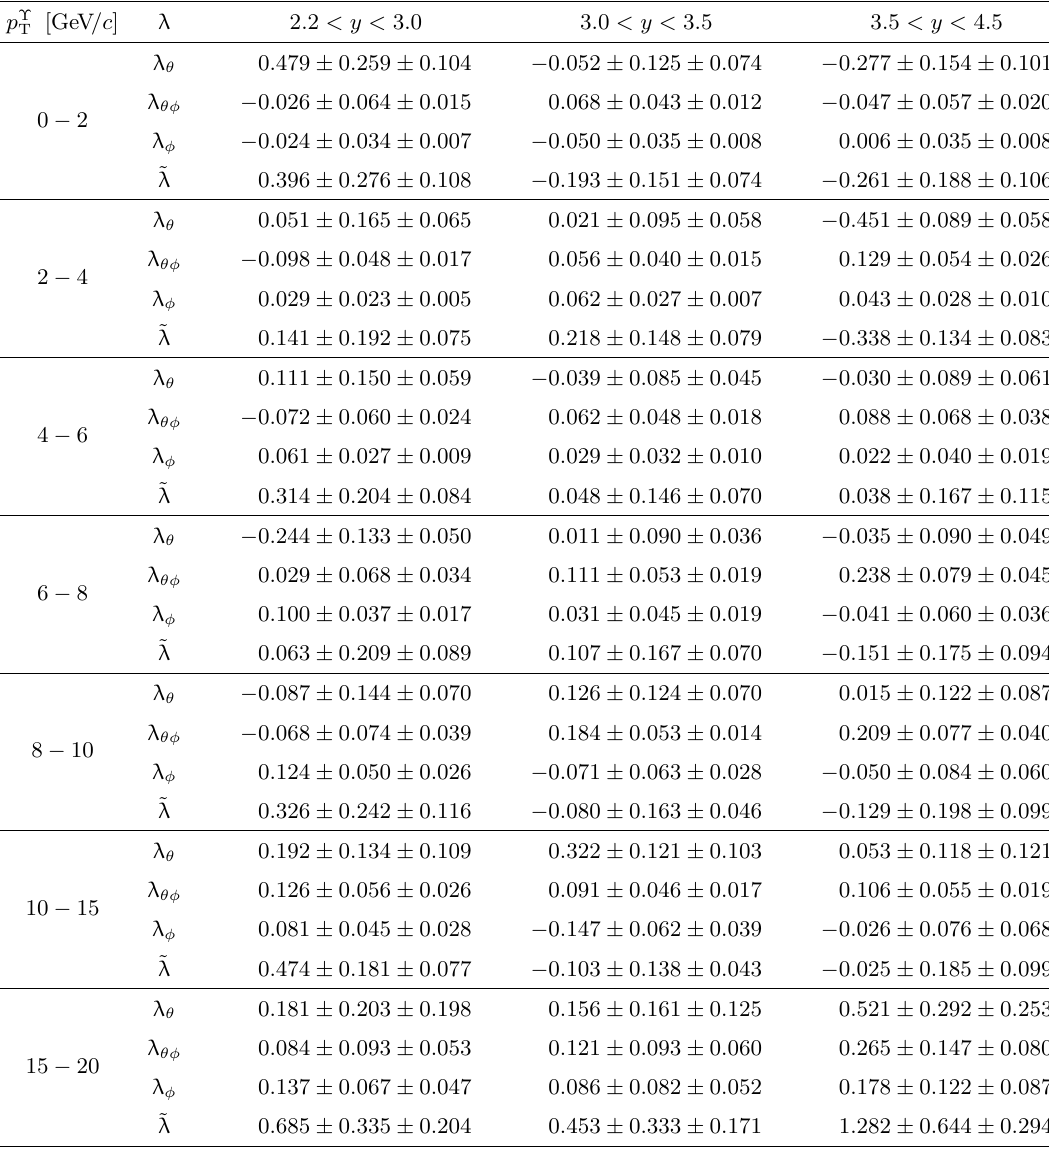
Table 20 . Values of (cid:21) (cid:18) , (cid:21) (cid:18)(cid:30) , (cid:21) (cid:30) and ~ (cid:21) measured in the HX frame for the (cid:7)(3S) produced at p s = 7 TeV. The (cid:12)rst uncertainty is statistical and the second systematic. C Polarization results for the (cid:7)(3S) state Values of the polarization parameters (cid:21)(cid:21)(cid:21) and ~ (cid:21) for the (cid:7)(3S) meson are presented in tables 20 and 21 for the HX frame, in tables 22 and 23 for the CS frame and in tables 24 and 25 p for the GJ frame for s = 7 and 8 TeV, respectively. The polarization parameters (cid:21)(cid:21)(cid:21) measured in the wide rapidity bin 2 : 2 < y (cid:7) < 4 : 5 are presented in tables 26 and 27, while the parameters ~ (cid:21) are listed in table 28.